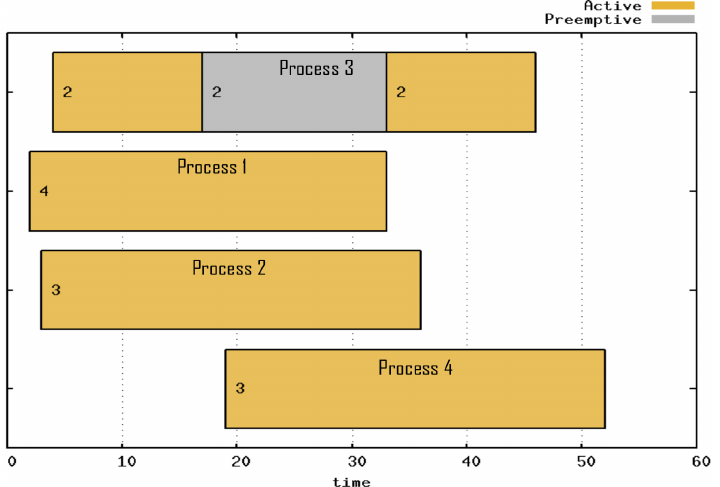
Figure 10. Gantt chart of Preemption, where process 3 was preempted because of process 4, with higher priority.